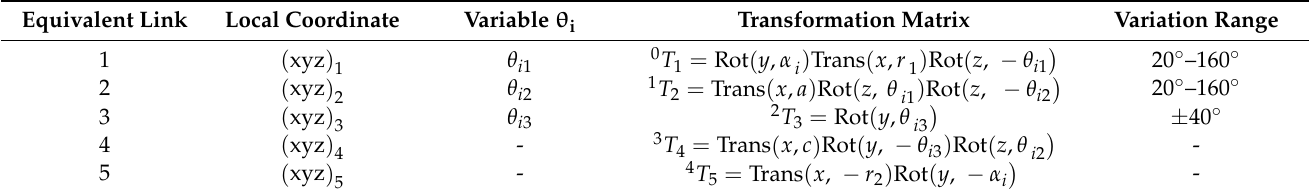
Figure 3. Kinematic sketch of each branch. Table 1. Equivalent link parameters of improved Delta